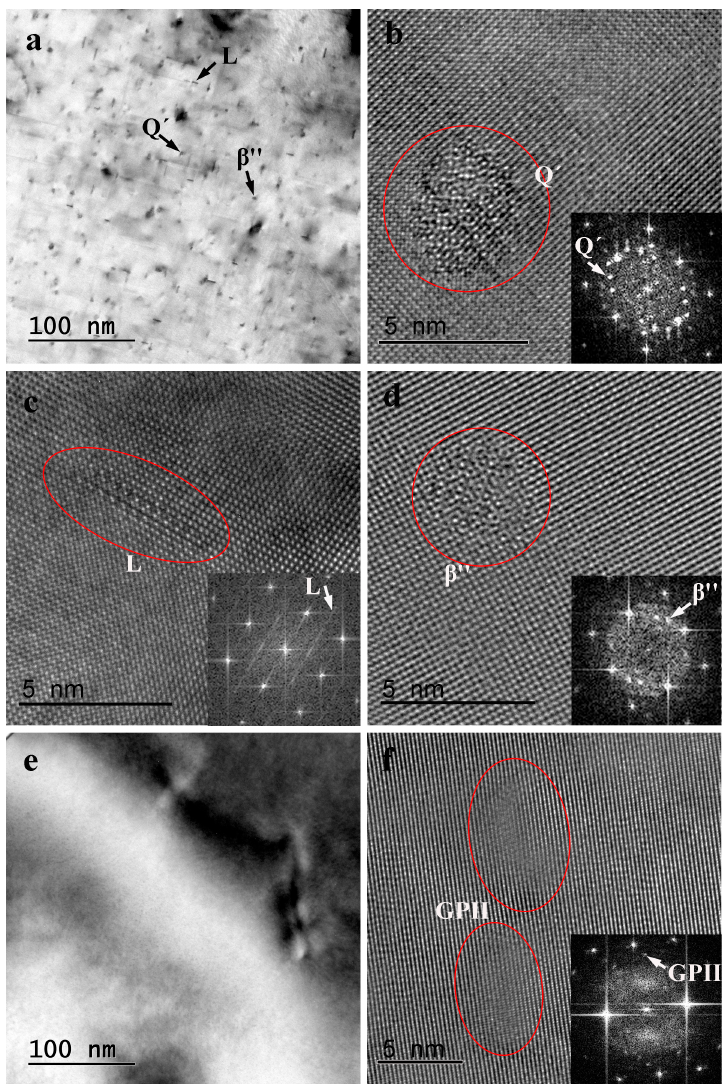
Figure 8. Transmission electron microscope (TEM) images of precipitates: ( a ) bright-field TEM images of the T6-treated 6061 matrix along <001> Al zone axis; ( b – d ) high-resolution transmission electron microscopy (HRTEM) images of different types of precipitates in (a), they are Q´ phase ( b ), L phase ( c ), β ’’ phase ( d ), respectively; ( e ) bright-field TEM images of the T6-treated 6061 matrix along <112> Al zone axis; and, ( f ) HRTEM image of GPII zones in ( c ). The inserts are the corresponding Fast Fourier Filtering transform (FFT) patterns.